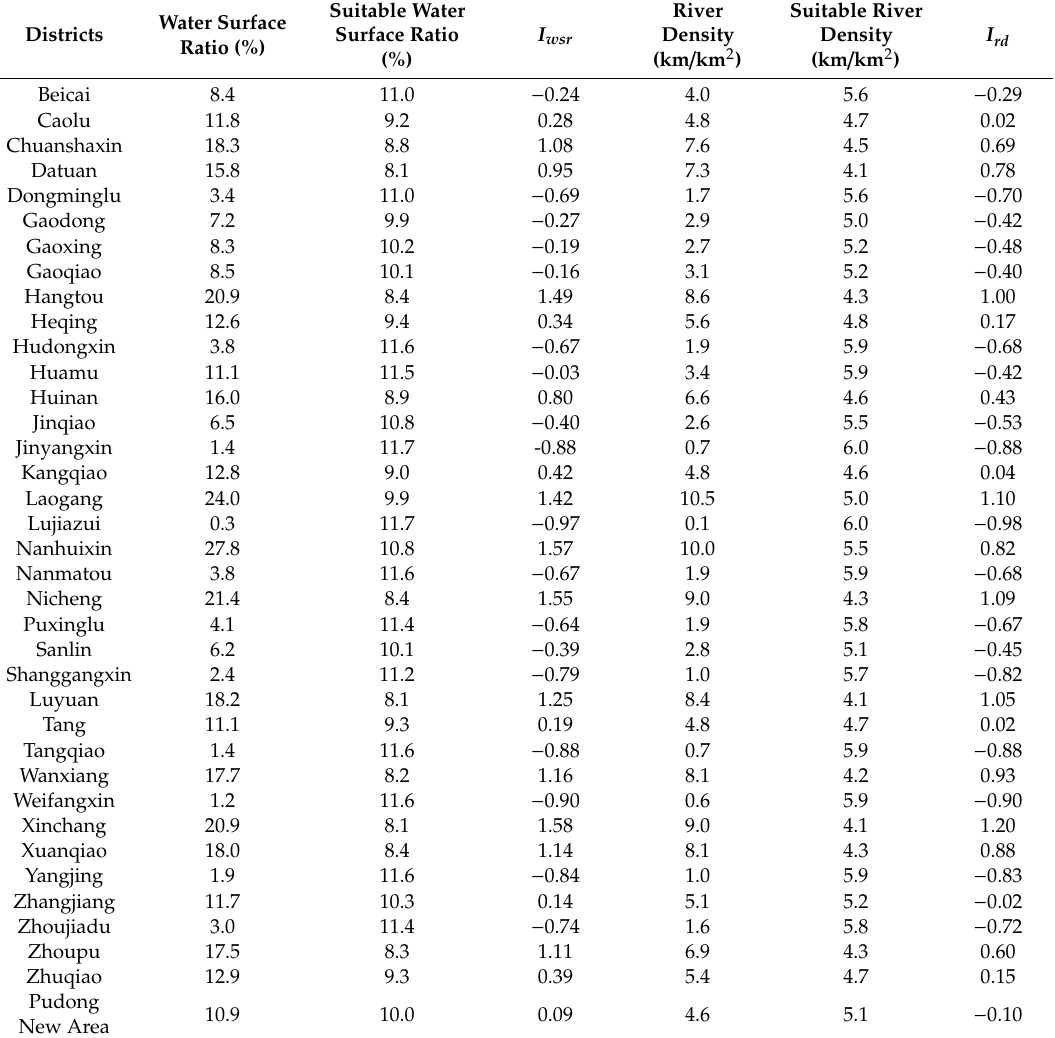
Table 2. Suitable river network structure of the Pudong New